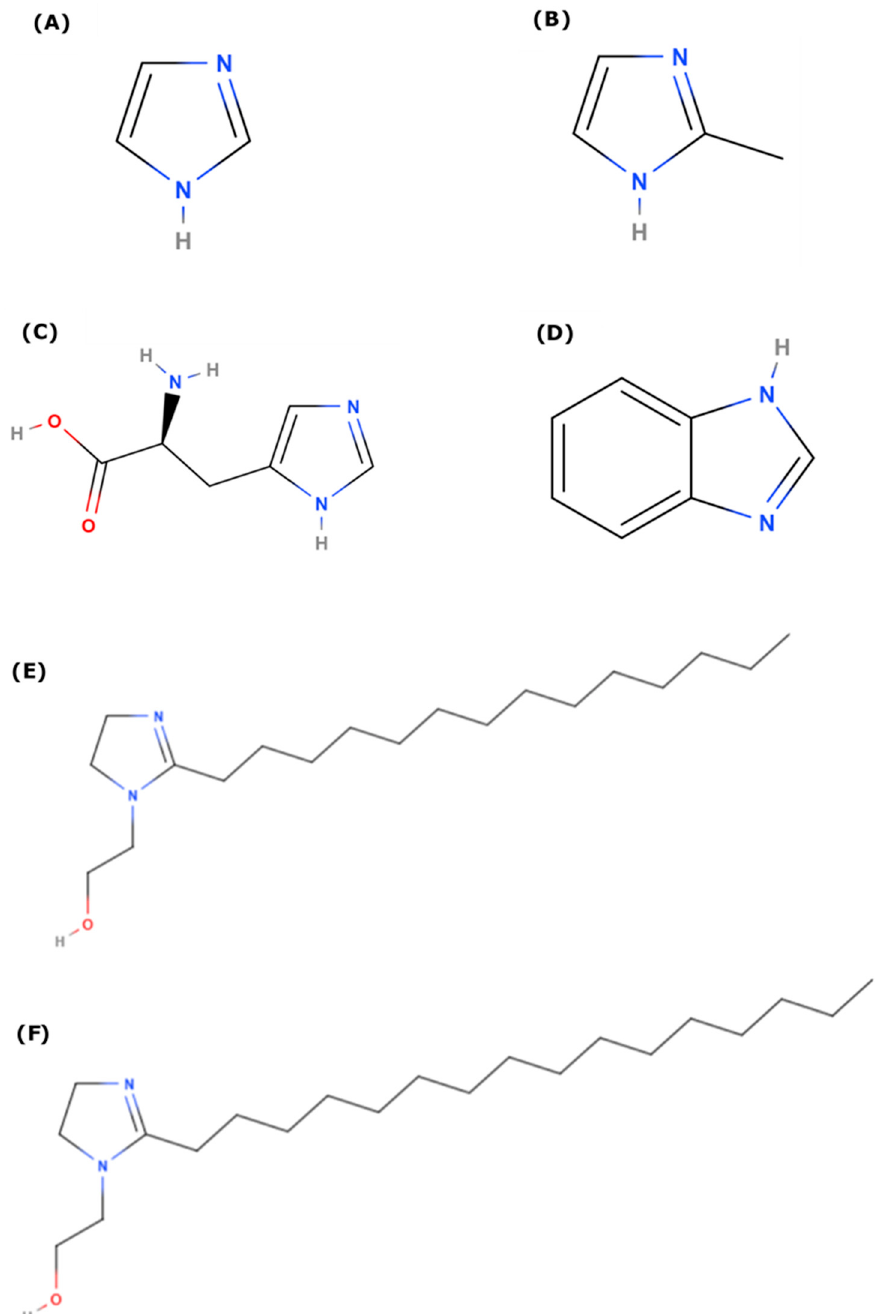
Figure 1. Molecular structure of different imidazole and imidazoline derivatives considered for this study ( A ) Imidazole (IMZ); ( B ) 2-Methyl Imidazole (Me-IMZ); ( C ) L -Histidine (L-HIS); ( D ) Benzimidazole (BI); ( E ) Imidazoline based surfactant with –(CH 2 ) 13 CH 3 as tail (IMZ_C14); ( F ) Imidazoline based surfactant with –(CH 2 ) 15 CH 3 as tail (IMZ_C16).